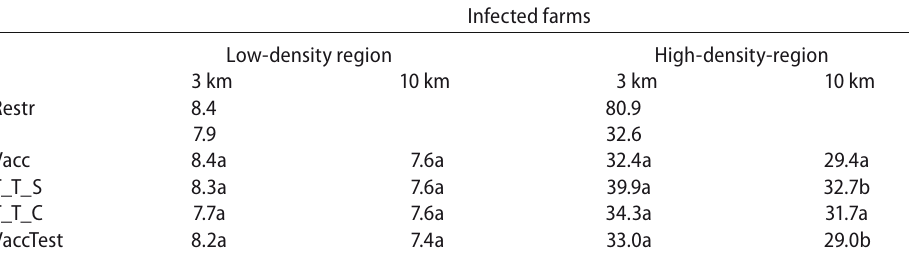
LSM number of infected and culled farms and their standard error for both regions for control strategies Restr, Trad, Vacc_3km, T_T_S_3km, T_T_C_3km and VaccTest_3km (Different letters indicate significant differences within number of infected respectively culled farms and region α=0.05)